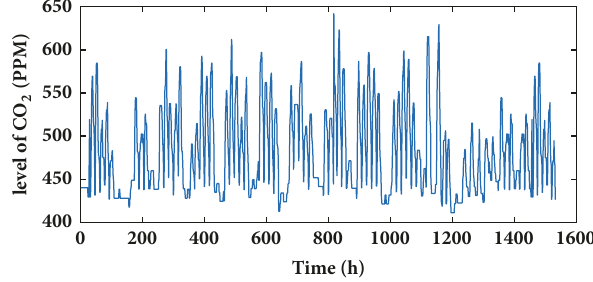
Figure 7: Level of CO 2 (in